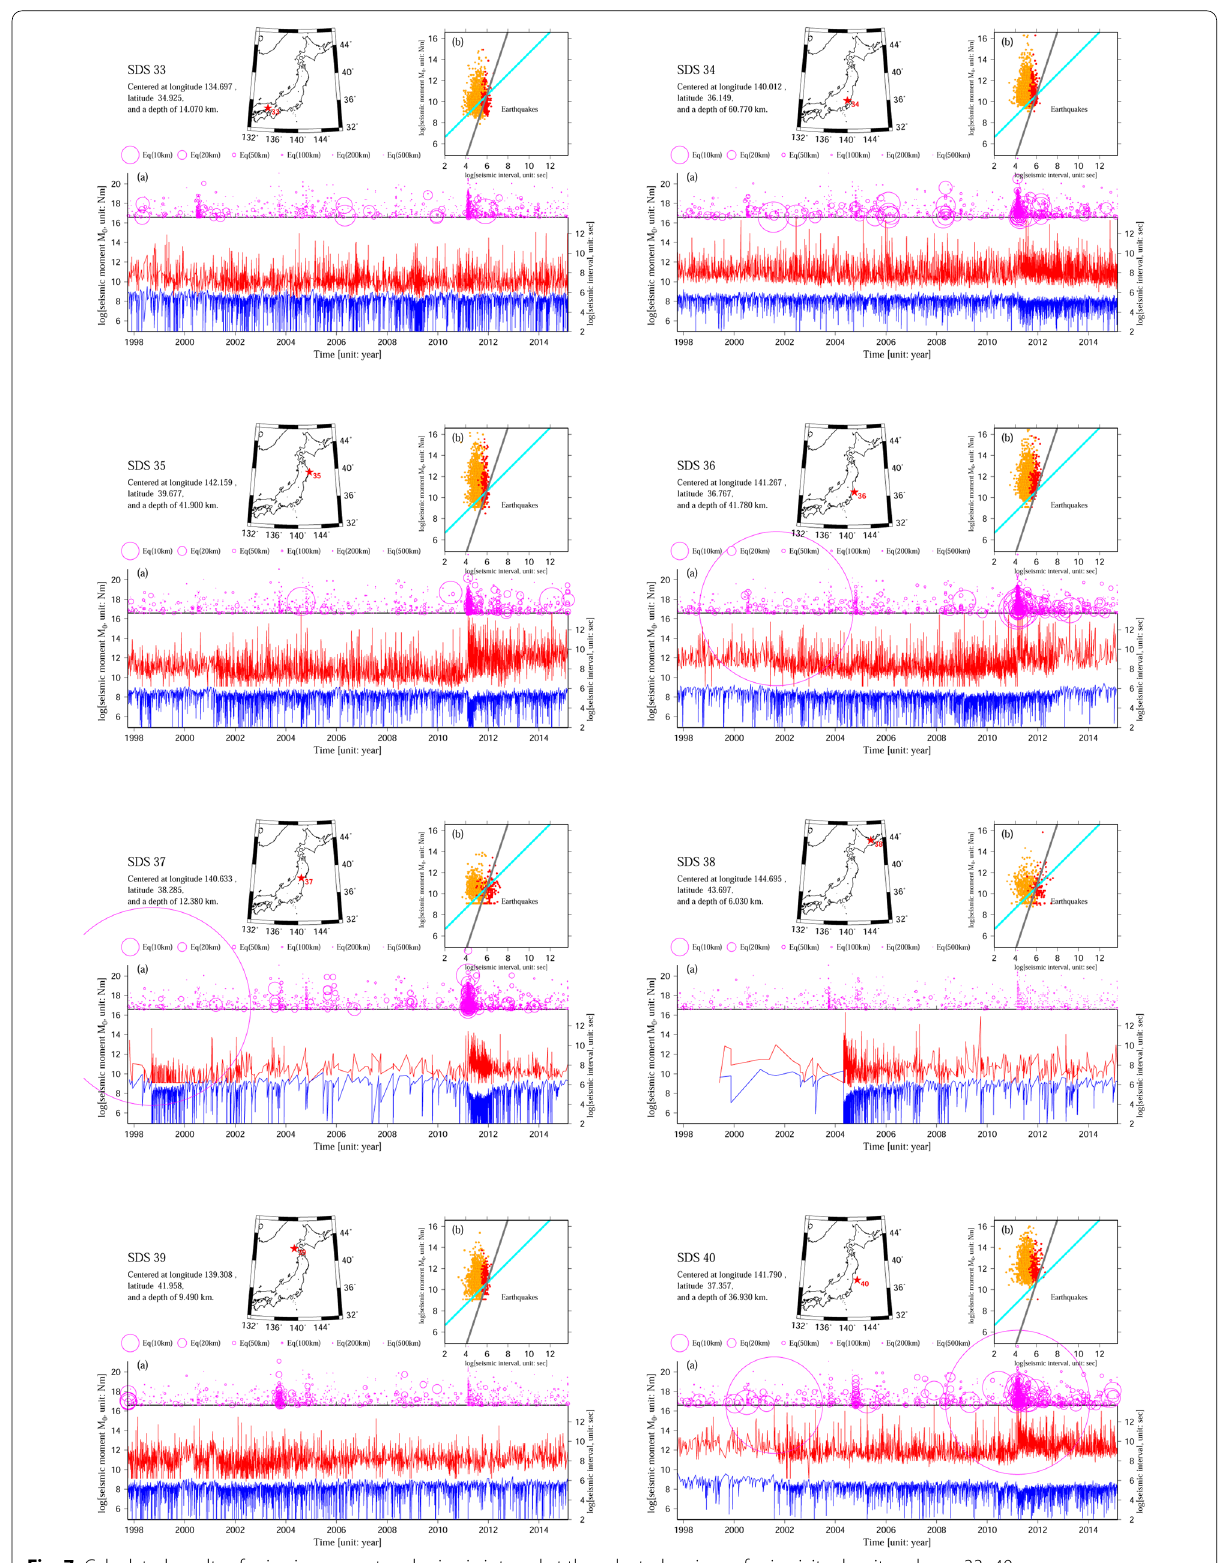
Fig. 7 Calculated results of seismic moment and seismic interval at the selected regions of seismicity density spheres